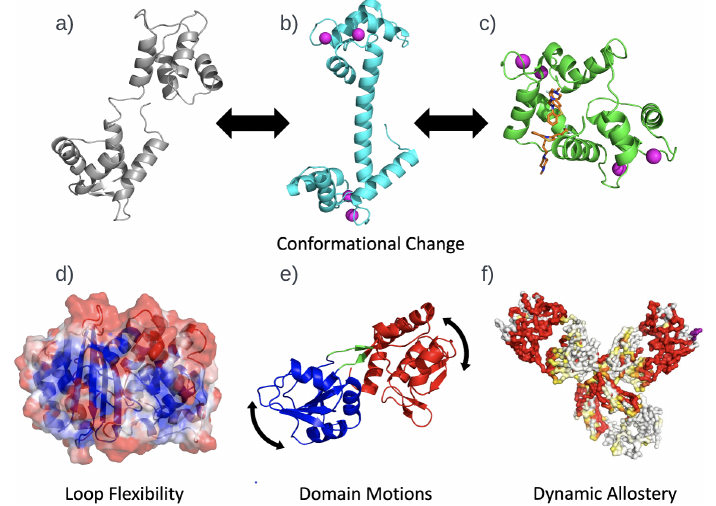
Figure 6. Examples of protein functional dynamics. In ( a – c ), three critical conformational states [297–299] of calmodulin are shown during the process of ligand binding. The unbound structure ( a ) binds to calcium ions ( b ), then the resulting structure is able to bind with a substrate ( c ) [300]. On the bottom row, ( d , e ) show the native state motions of proteins including surface loop flexibility [301,302] and concerted domain fluctuations [303]. ( f ) A visual of dynamic allostery pathways resulting from changes to the vibrational modes of a protein upon binding a ligand